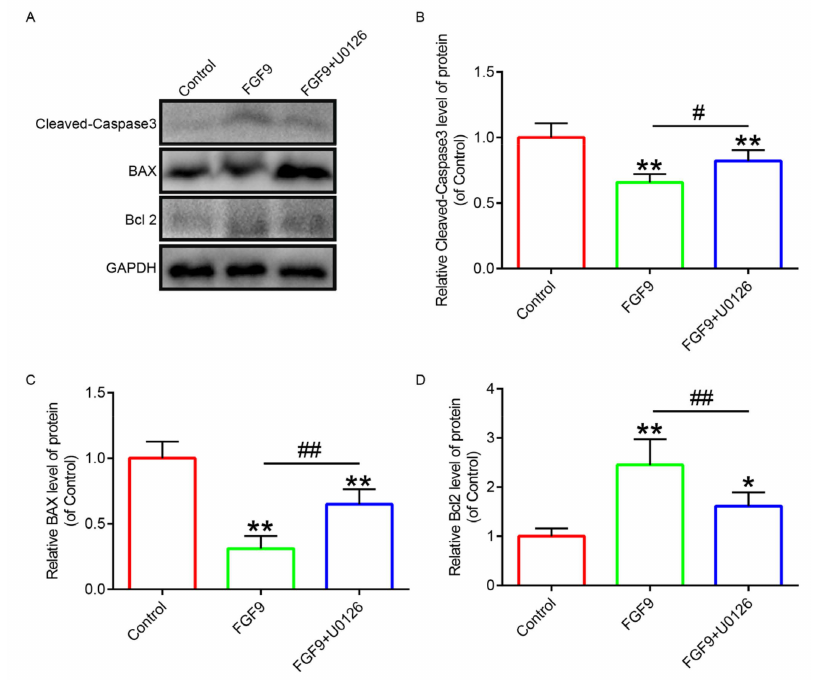
Figure 8. FGF9 promoted the upregulation of cleaved caspase-3, Bax, and Bcl2 expressions. ( A ) West- ern blotting images of the above three apoptosis-related proteins. ( B – D ) Quantitative statistics of the optical density values of the three proteins. * and ** indicate p < 0.05 and p < 0.01 against the control group; # and ## represent p < 0.05 and p < 0.01, respectively, comparing the FGF9 group with the FGF9+U0126 group, indicating statistical significance. Data are the mean values ± SD, n =